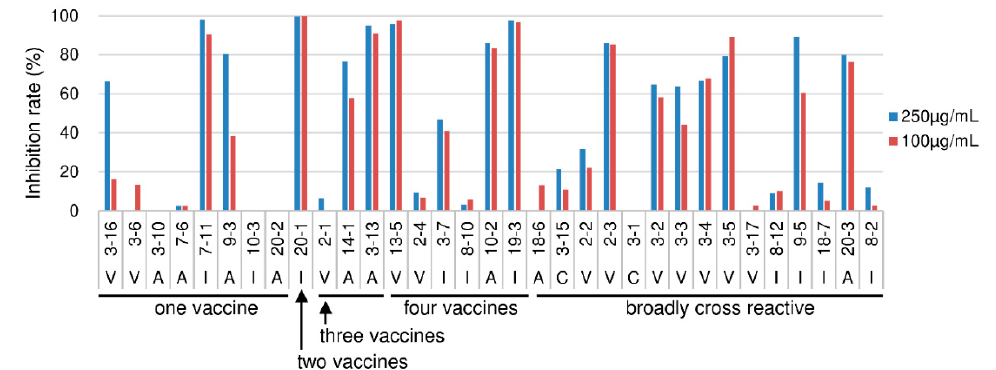
Figure 5. Neutralization activity of Fab-PP from HI-negative clones was measured by focus reduction assay. Neutralization activity was tested at two antibody concentrations (250 µg/mL, blue bars; and 100 µg/mL, red bars). Three kinds of H5N1 viruses were tested, including V: Vie04 (Clade 1), I: Ind05 (Clade 2.1), and A: Anh05 (Clade 2.3); the strain used for each assay is indicated under the clone name. The neutralization activity is shown as the focus reduction rate (%) normalized to that observed in the absence of antibody.